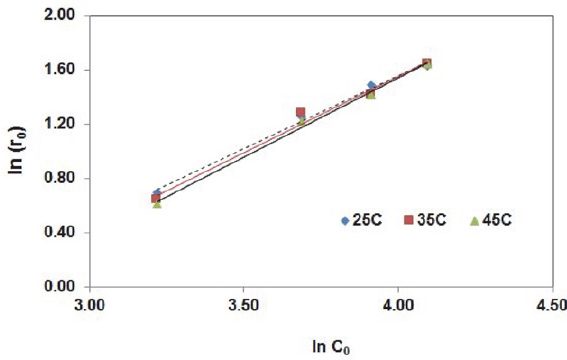
Fig. 11. ln(r 0 ) versus lnC 0 (initial pH: original, H 2 O 2 amount: 2.78 g/L, m-ZZF amount: 3 g/L, CaCl 2 amount: 3.75 g/L, UV light)